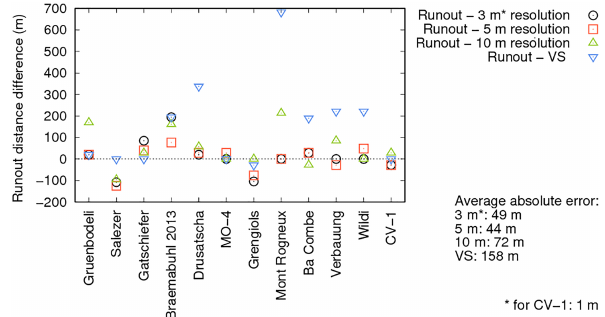
Figure 10. Runout error plot comparing thermomechanical wet- snow model calculations (black dots) with guideline-VS runout calculations (blue triangles), as well as runout calculations with 5 and 10m model resolution with the thermomechanical model (red squares and green triangles, respectively). The legend shows the ab- solute average simulation error for each set of simulations. It was necessary to simulate the CV-1 case with a 1m grid resolution to better account for a vertical